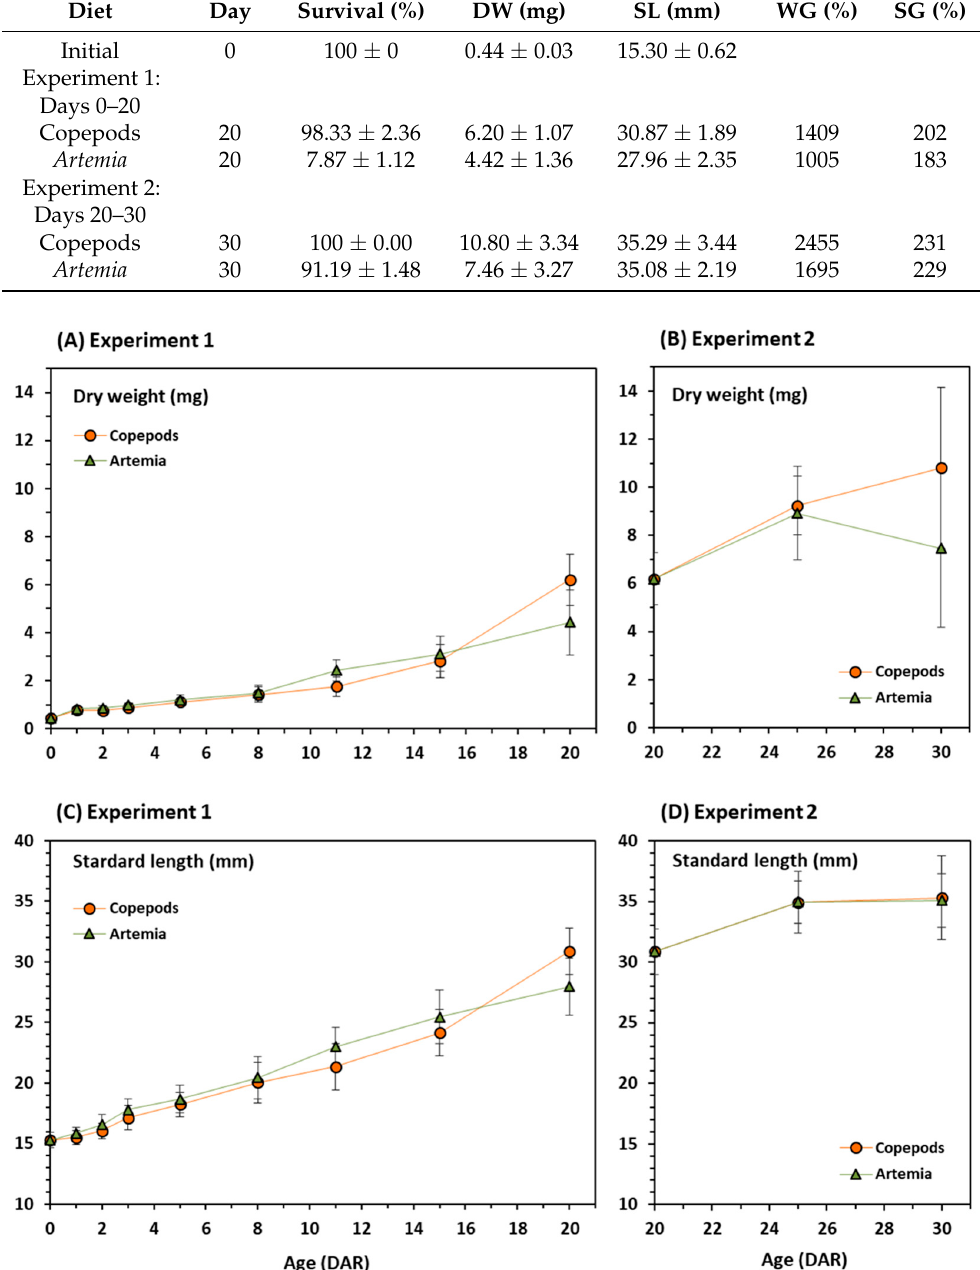
guttulatus . ( A , C ): Experiment 1—Juveniles fed on Artemia (nauplii and metanauplii) or copepods Figure 1. Growth ( A , B —dry weight and C , D —standard length) of juvenile seahorses Hippocampus guttulatus . A , C : Ex- until 20 DAR; ( B , D ): Experiment 2—Juveniles fed on copepods in Experiment 1 until 20 DAR and periment 1—Juveniles fed on Artemia (nauplii and metanauplii) or copepods until 20 DAR; B , D : Experiment 2—Juveniles fed on copepods in Experiment 1 until 20 DAR and subsequently fed on Artemia (nauplii and metanauplii) or copepods subsequently fed on Artemia (nauplii and metanauplii) or copepods until 30 DAR. Means and until 30 DAR. Means and standard deviations are represented. standard deviations are